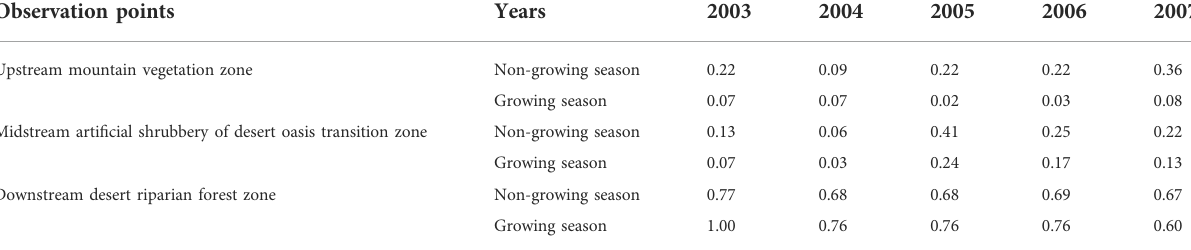
TABLE 3 Variation coef fi cient of soil water